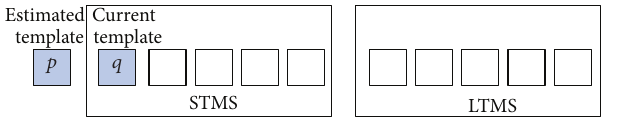
Figure 5: Initialization step.